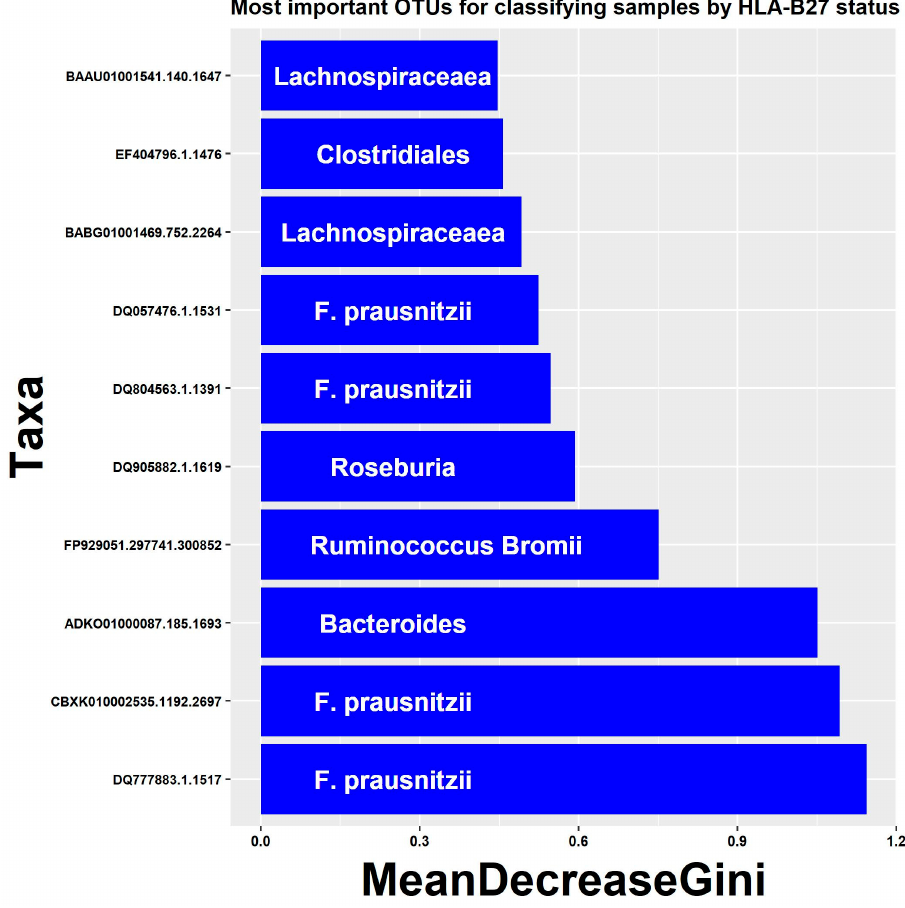
Figure 3. Results of random forest algorithm to identify features associated with HLA-B27 status. The top 10 most important features based upon the MeanDecreaseGini coefficient are shown.